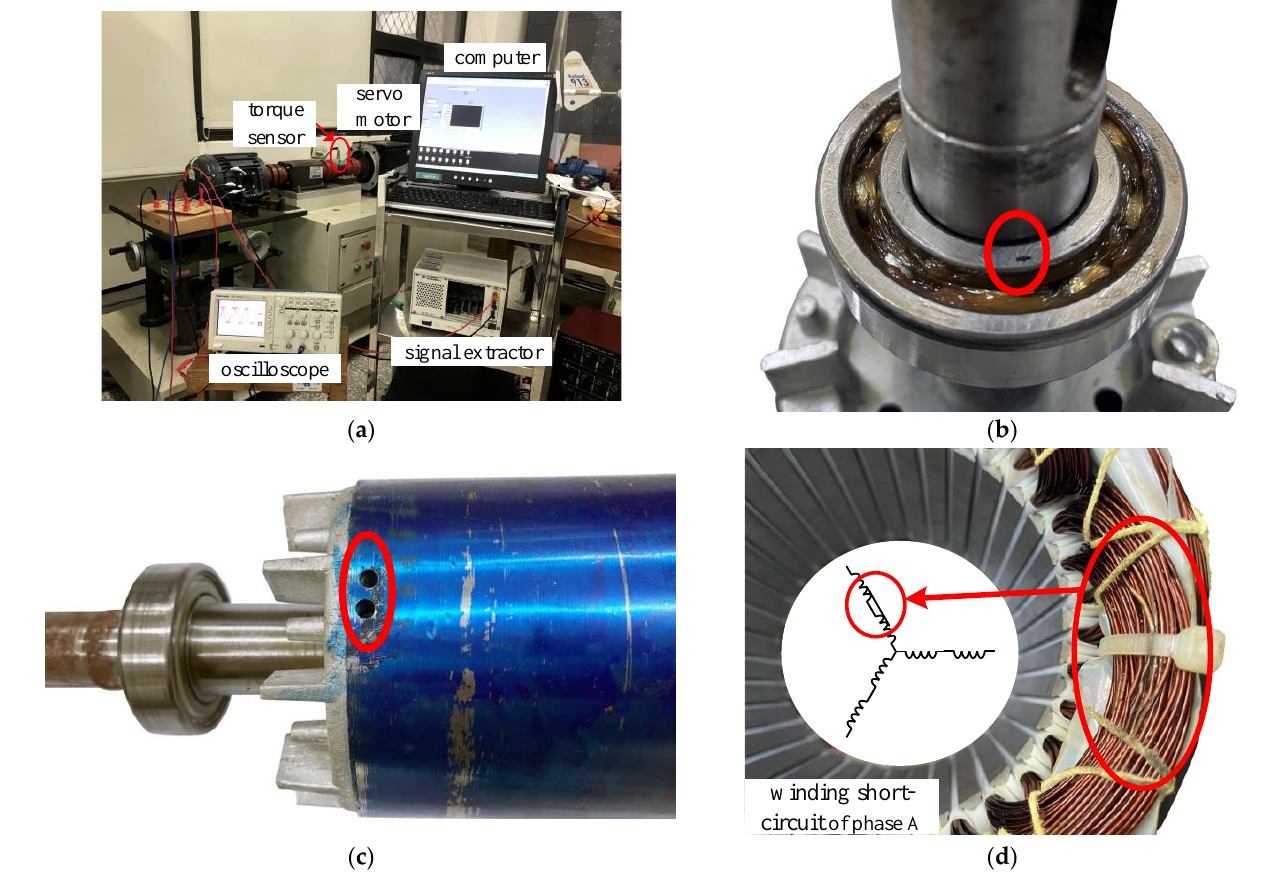
Figure 10. ( a ) Servo motor, oscilloscope, computer, torque sensor, signal extractor, ( b ) broken bearings motor (Aperture 1.96 mm × 0.53 mm), ( c ) broken rotor bar motor (2 holes ∮ 8 mm deep 10 mm), ( d ) stator winding short-circuit motor (2 coils). Table 1. The three-phase squirrel-cage induction motor specifications. Voltage